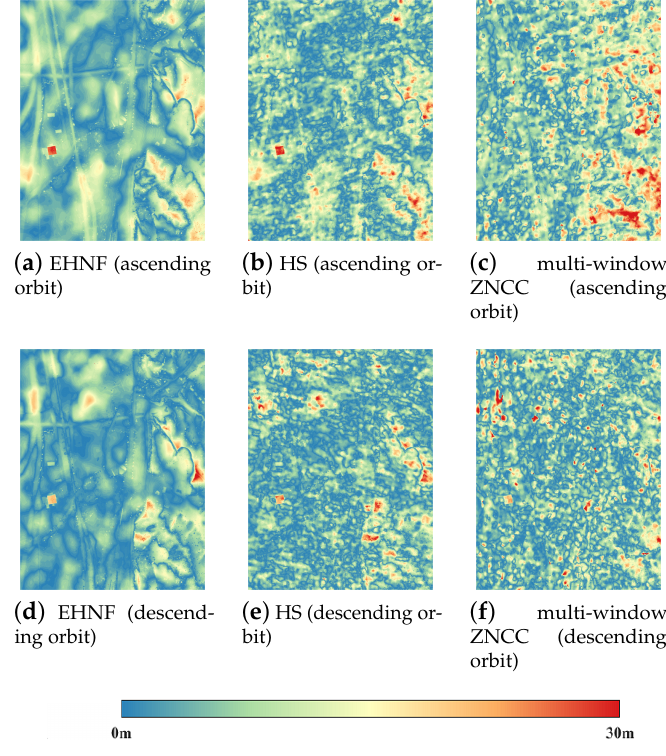
Figure 10. The root square error of flat DSM generated by the ( a ) EHNF algorithm; ( b ) HS flow algorithm; ( c ) multi-window ZNCC algorithm of ascending orbit stereo images, and ( d ) EHNF algorithm; ( e ) HS flow algorithm; ( f ) multi-window ZNCC algorithm of descending orbit stereo